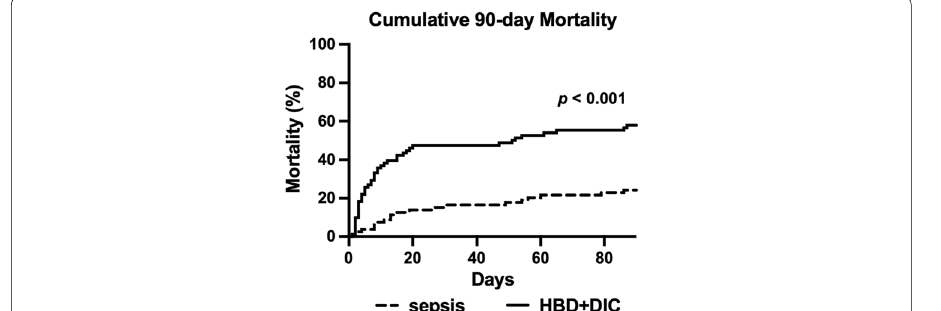
Fig. 1 HBD DIC phenotype in sepsis is marked by higher mortality. Unadjusted Kaplan–Meier curve + comparing cumulative 90-day mortality in sepsis controls vs sepsis with HBD